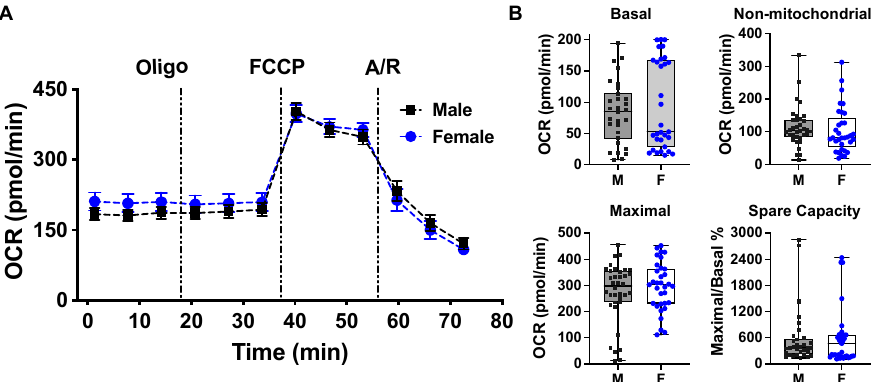
Figure 2. Metabolic profiling between cardiomyocytes isolated from adult male and female mice